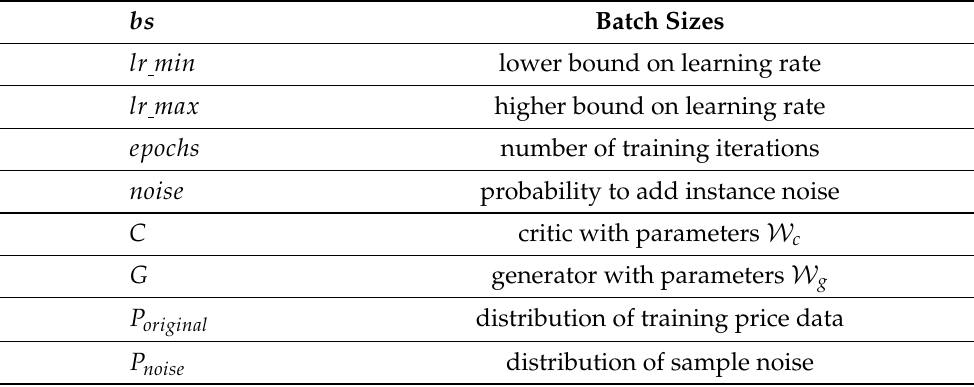
Table 1. Parameters settings for WGAN-GP, a combination of different parameter settings, can approach the optimal loss efficiently. We outlined the parameters for training considerations.